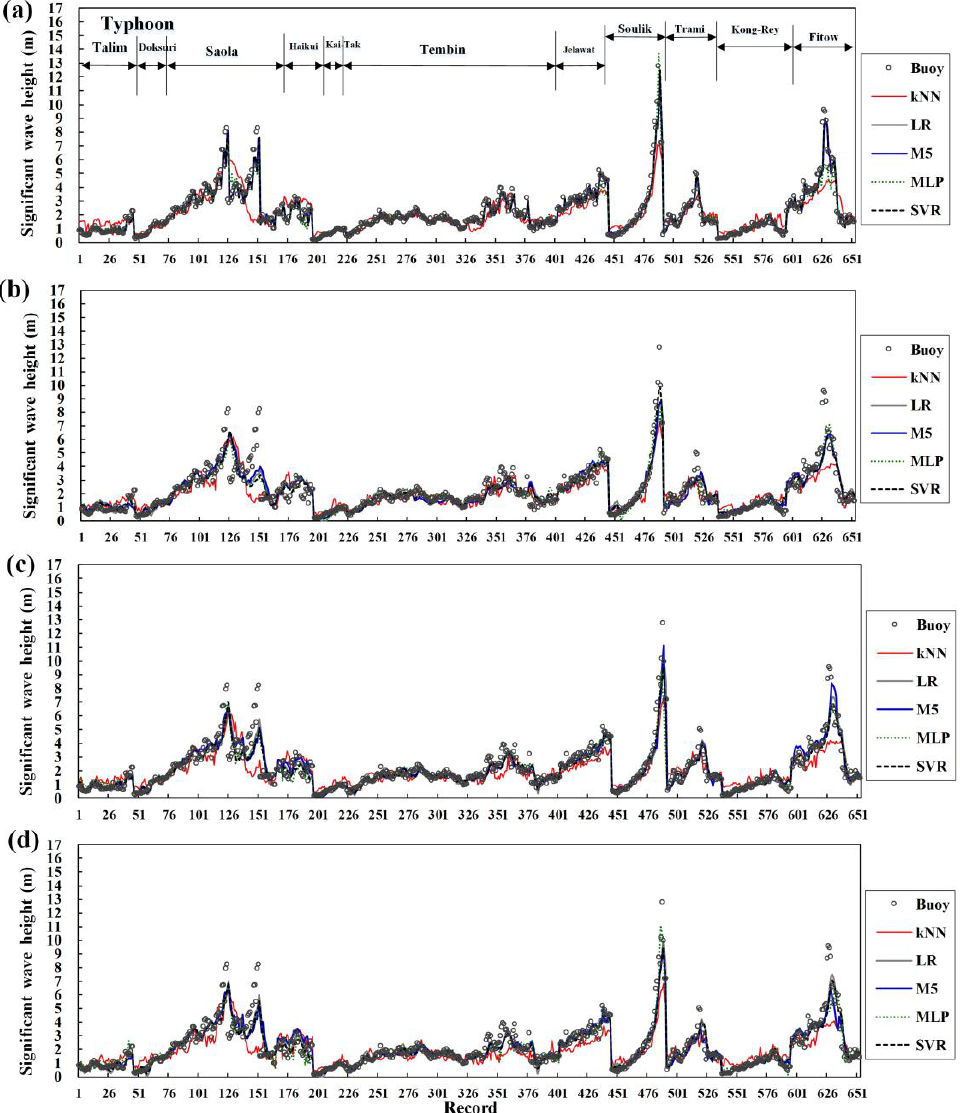
Figure 5. Prediction results of testing typhoons (2012–2013) for ( a ) ORI, ( b ) EV1, ( c ) TV90, and ( d ) TV95. LR: linear regressions; M5: model trees; MLP: multilayer perceptron; SVR: support vector regression.